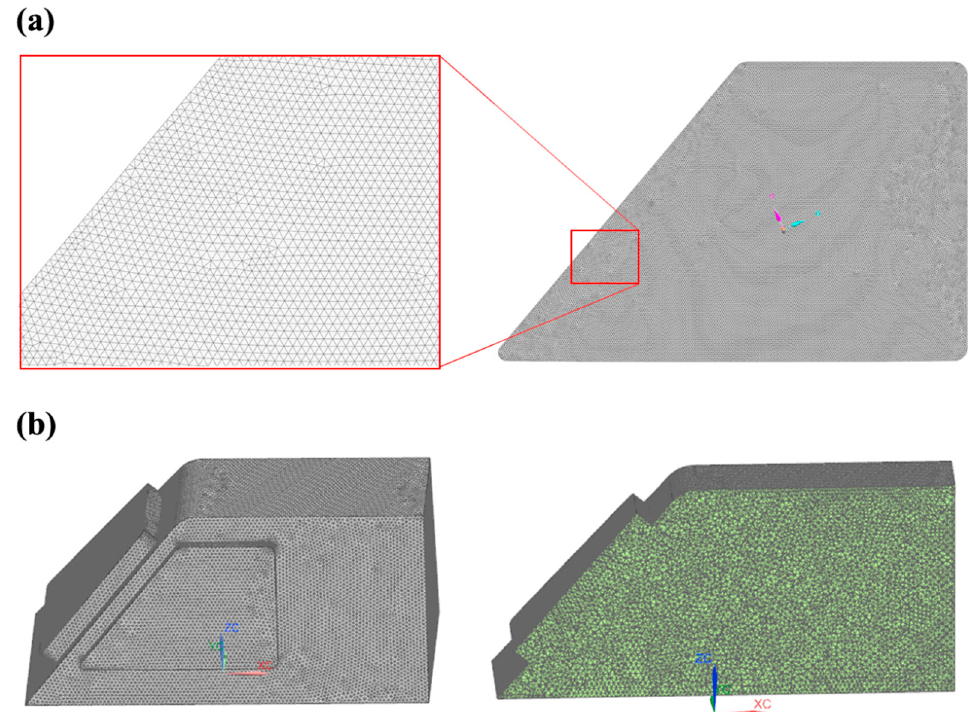
Figure 15. Configuration of computational grids: ( a ) 2D shell elements of glass windows; ( b ) 3D tetrahedral elements of acoustic cavity.